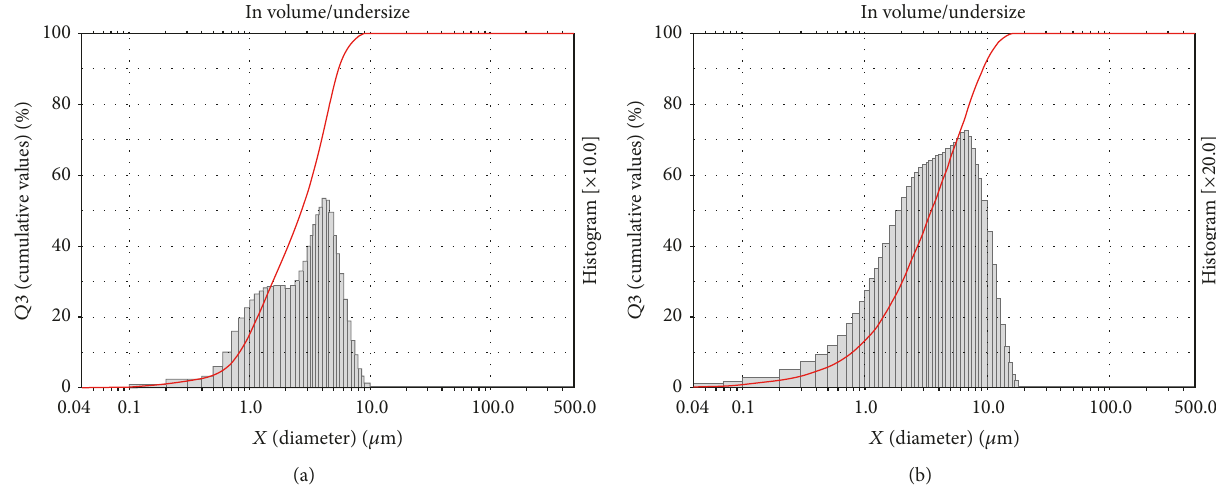
Figure 7: Particle size distribution grid of (a) hydro aerated calcined Razor shell CaO; (b) nonaerated calcined Razor shell